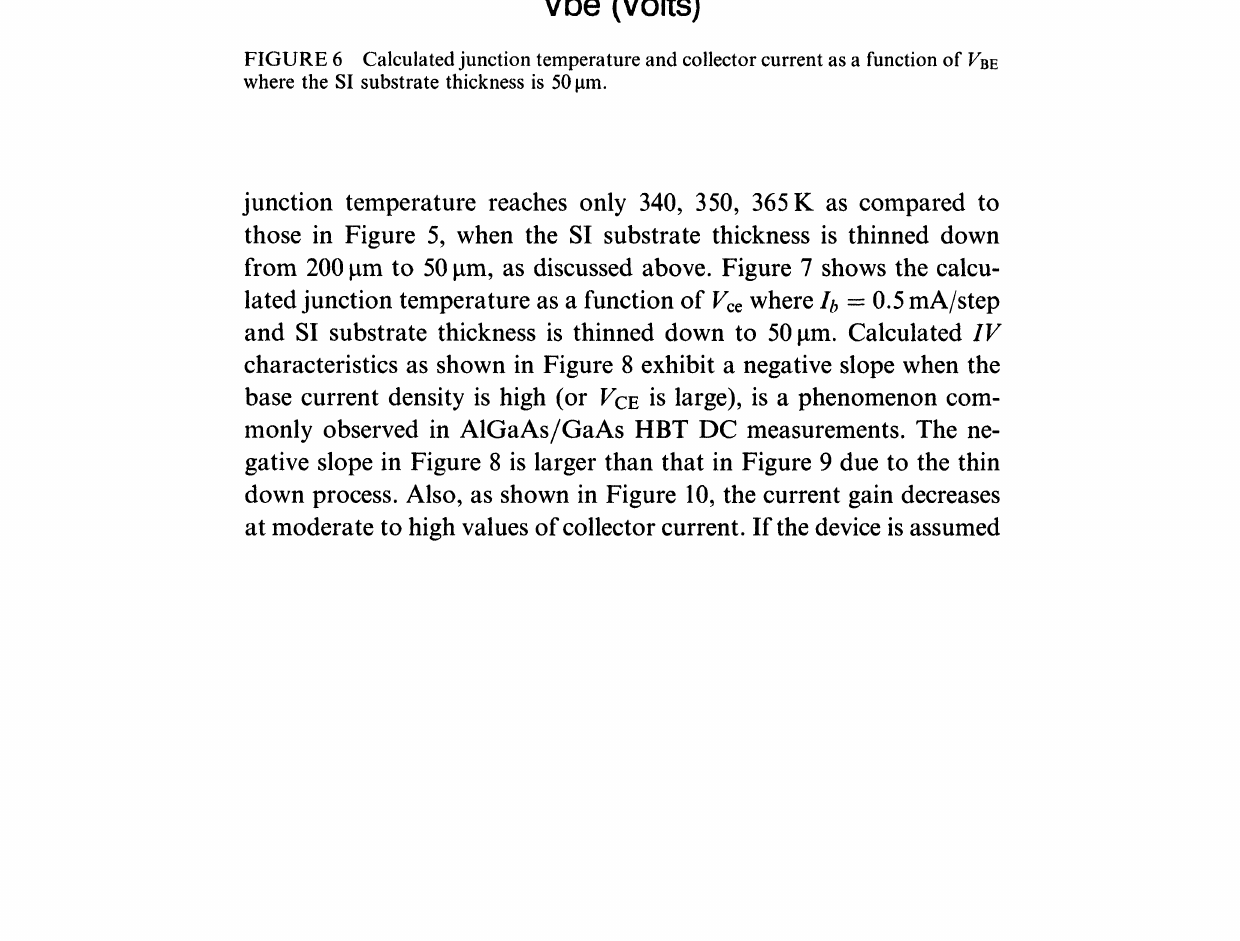
FIGURE 6 Calculated junction temperature and collector current as a function of VaE where the SI substrate thickness is 50